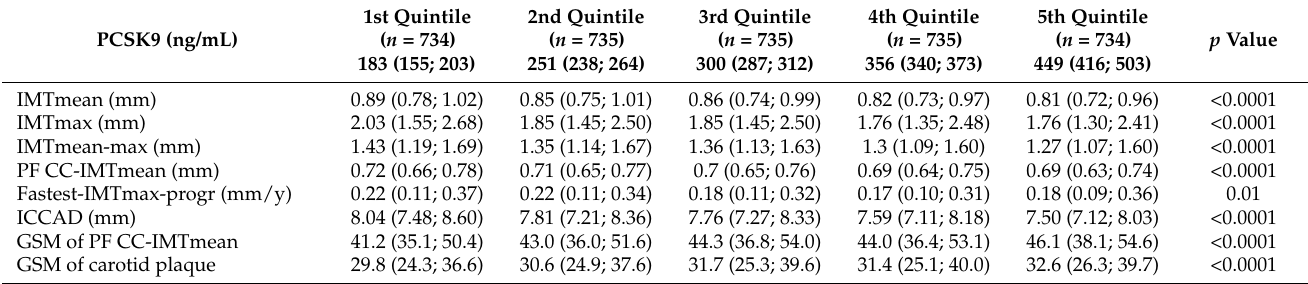
Table 2. Ultrasonographic variables of the IMPROVE study cohort stratified by quintiles of plasma PCSK9 levels (ng/mL). PCSK9 (ng/mL)